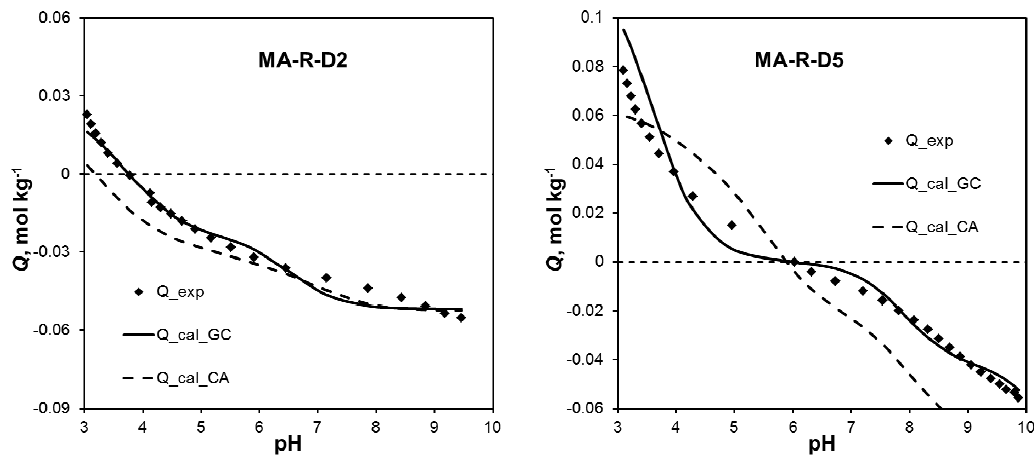
Figure 1: MA – Ruprechtov site samples (D2, D5) – titration curves evaluated using GC- and CA-approach